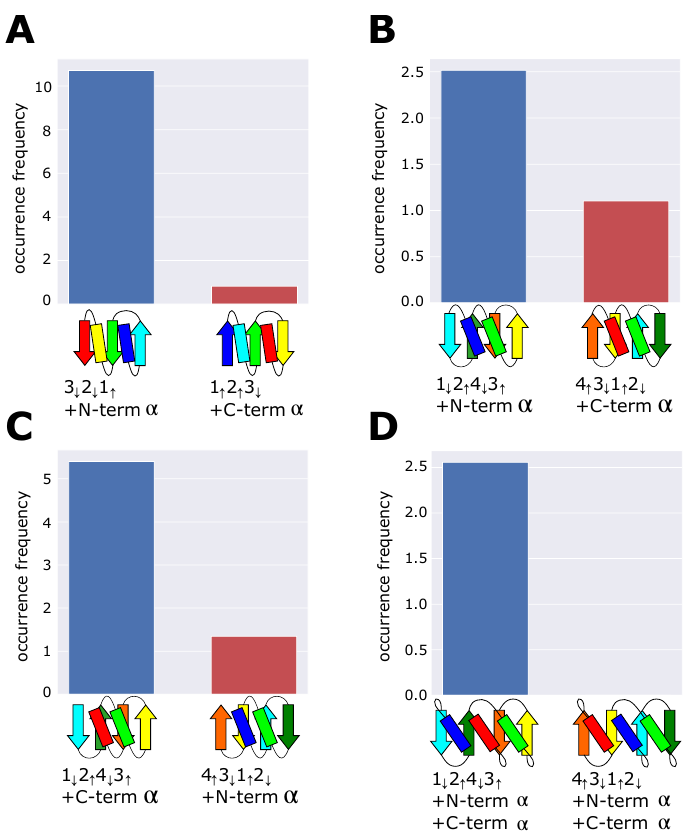
Figure 4. Comparisons of occurrence frequency between topologies minimizing frustration and their reverse topologies exhibiting